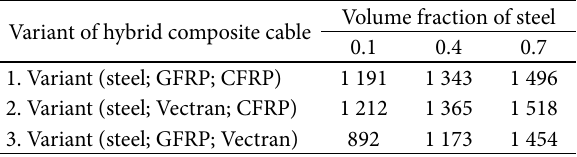
Table 1. Max axial forces for 3 variants of hybrid composite cable, kN